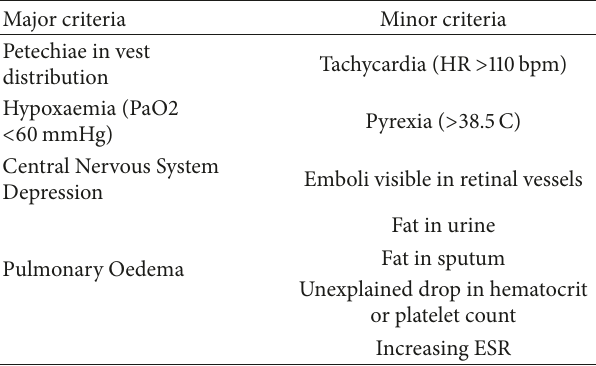
Table 1: Gurd and Wilson criteria for diagnosis of fat